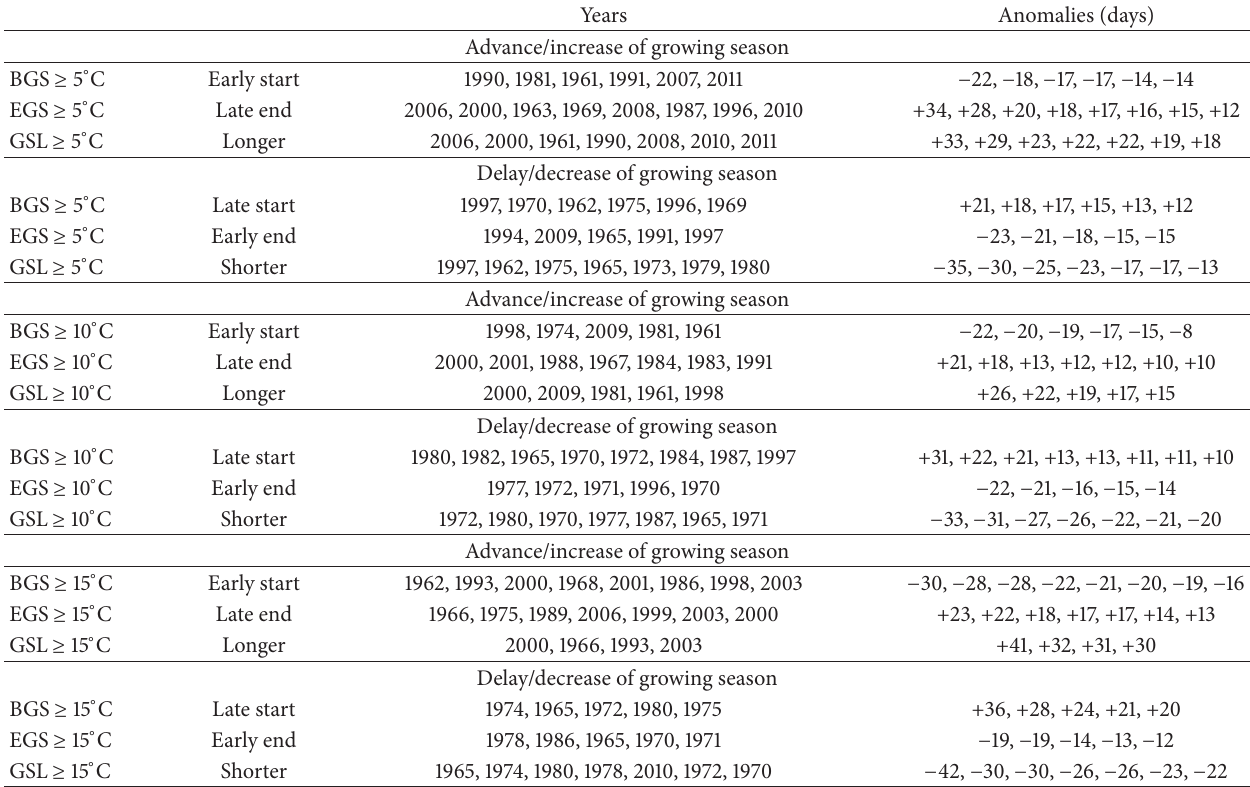
Table 2: Area-averaged anomalies (sorted by the highest number of anomalies in days) in the start, end, and length of the growing season ≥ 5, 10, and 15 ∘ C over the Elbe River lowland for 1961–2011. for the three thresholds of 𝑇 mean Years Anomalies